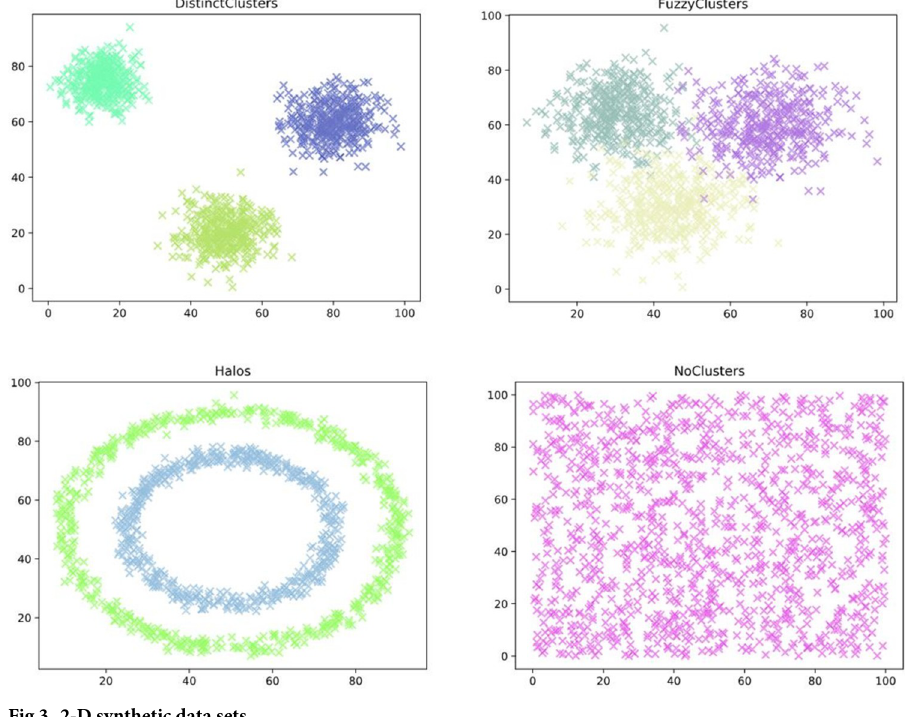
Fig 3. 2-D synthetic data sets.